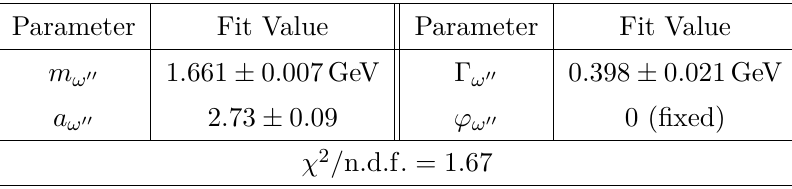
Table 4 . Values obtained by the fit for the e + e − → ωππ current. The phase ϕ ω 00 was fixed at 0 .